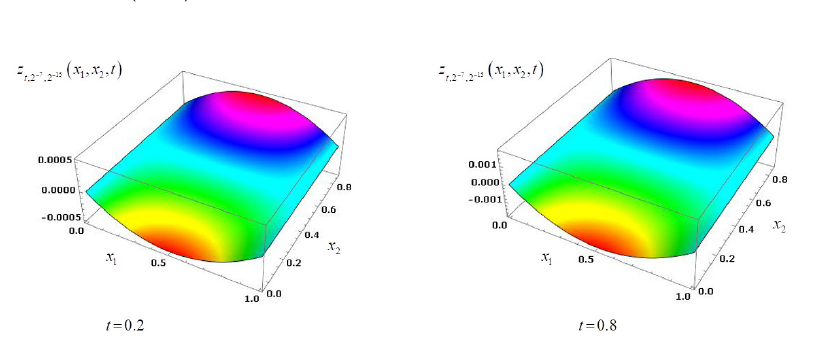
Figure 9. The approximate solution z t ,2 − 7 ,2 − 15 at time levels t = 0.2 and t = 0.8 obtained by the (cid:16) (cid:17) ∂ 2 u method H 4 th for the Example ∂ x 2 ∂ t